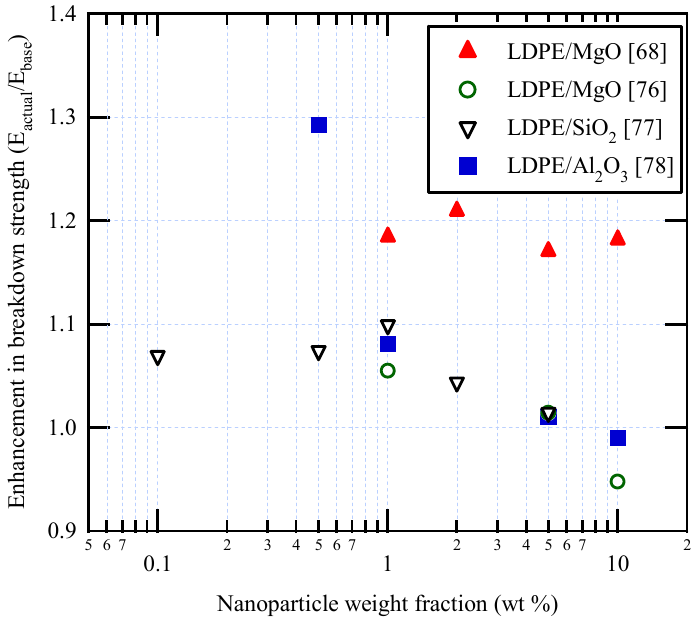
Figure 6. Some published data for impulse breakdown strength in polymer nanocomposites.